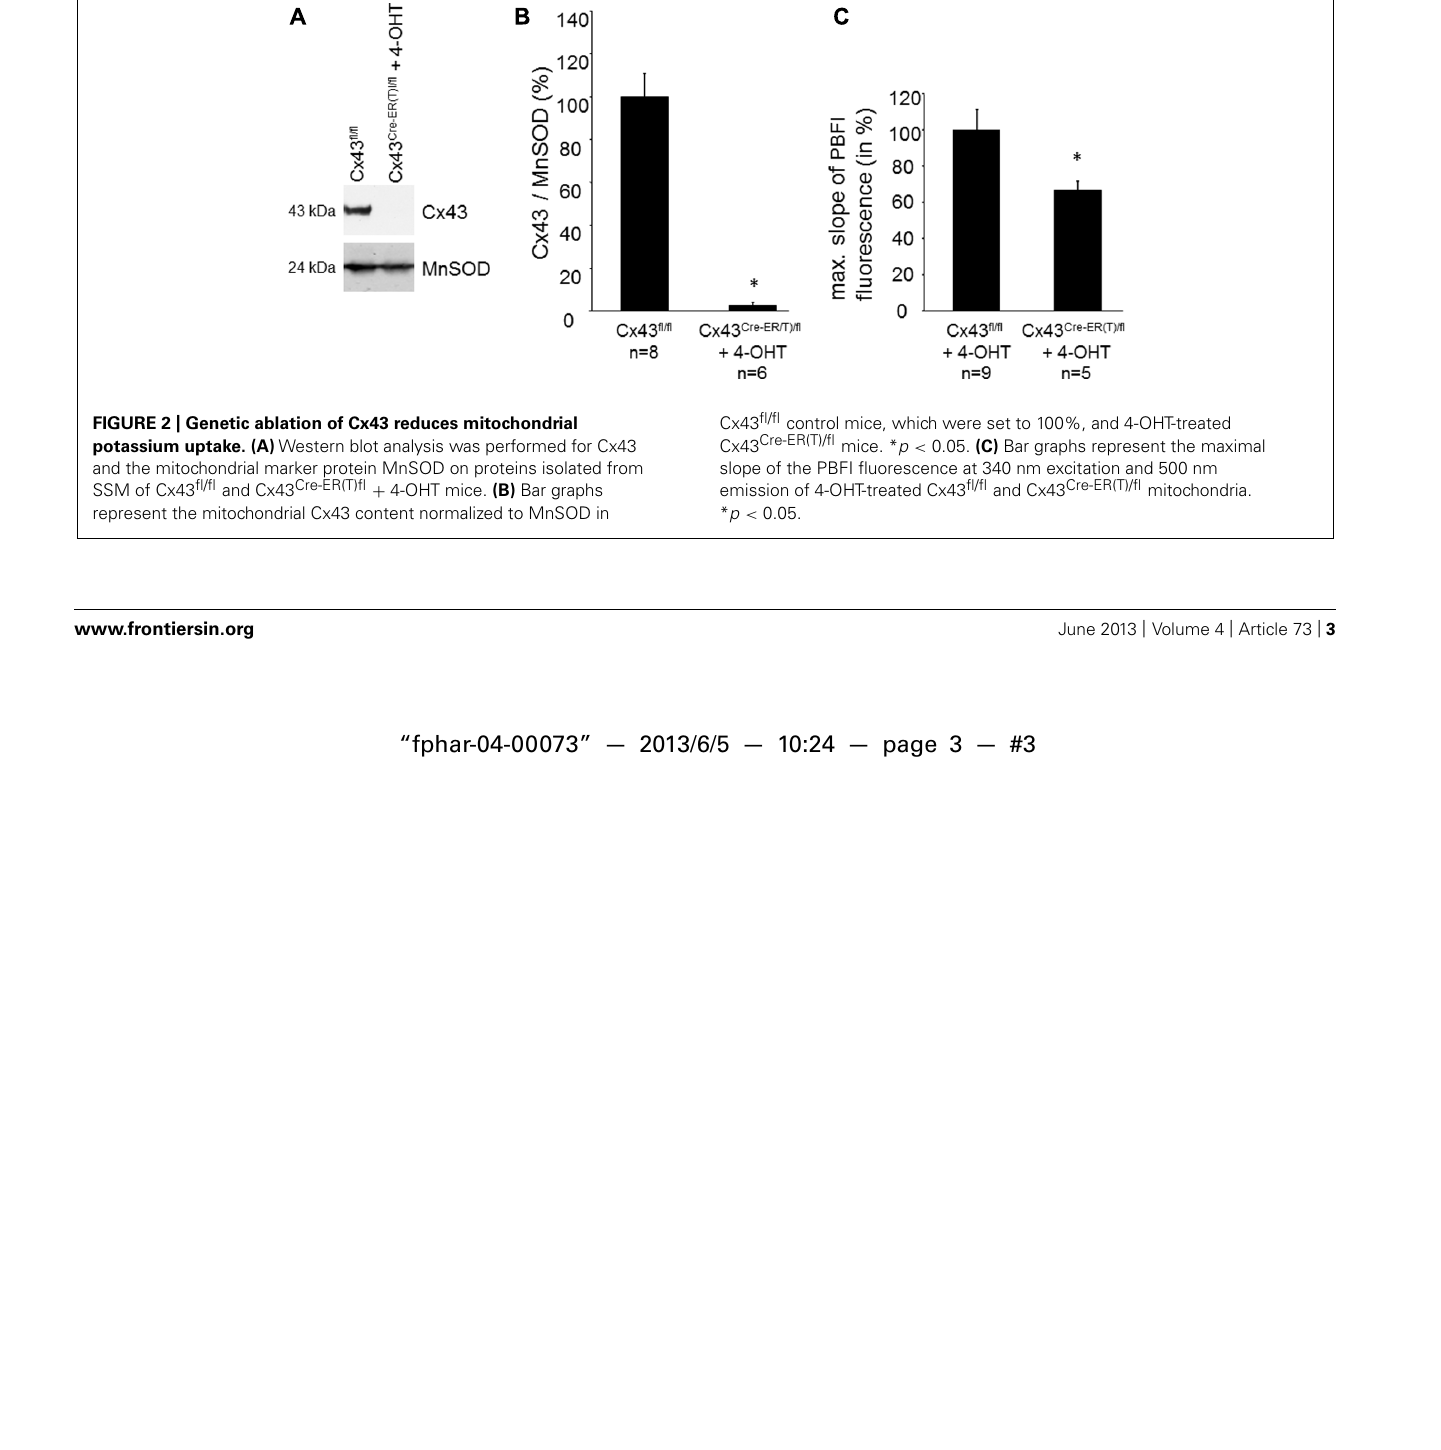
380 nm excitation and 500 nm emission, respectively. (B) Bar graphs represent the maximal slope of the PBFI fluorescence at 340 nm excitation and 500 nm emission of control and Gap19-treated mitochondria. * p < 0.05.